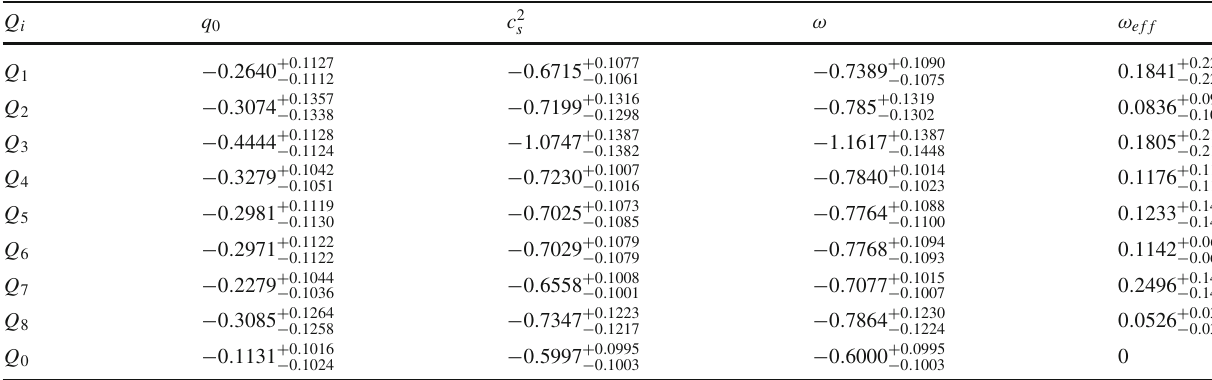
Table 3 The present-day values of the deceleration parameter q 0 , adia- respectively. The model Q 0 corresponds to the choice b = 0, i.e. no interactionbetweendarkenergyanddarkmatter.Thebestmodelinlight baticspeedofsoundsquaredforthedarkenergyfluid c 2 s = ∂ p ∂ρ ,andthe de of the cosmic chronometers data is Q 8 (see Table 2). The uncertainties and dark effective equation of state parameters for dark energy ω = p ρ are hugely affected by the errors on the datapoints at high redshift z ∼ 2 de matter ω ef f = (cid:9) ρ for each cosmological model. These quantities have and on the datapoint at z = 0 . 48 (see Table 1). A complete discussion m been computed from those in Table 2 and the corresponding error bars on the cosmological consequences of the results here presented can be are found by applying the propagating formula (27). The expressions found in Sect. for the interaction terms Q 1 ,..., Q 8 can be found in (12), ..., (19)